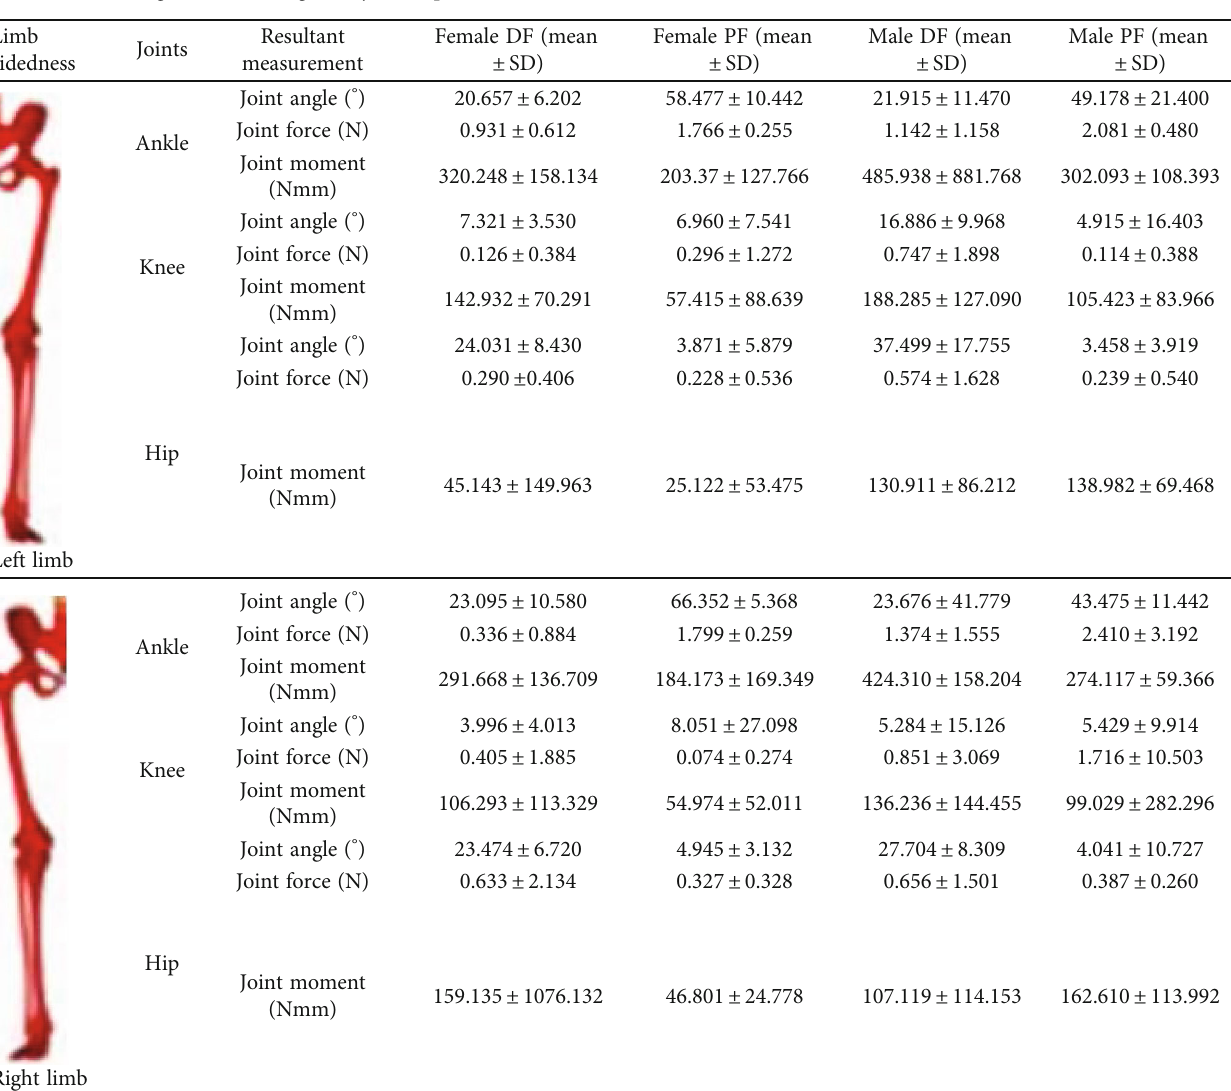
Table 3: Range of Motion (Joint Angle), Range of Forces and Moments Output – Resultant measurements at the ankle, hip and knee joints for both left and right limbs during the dynamic phases of the trial ( °